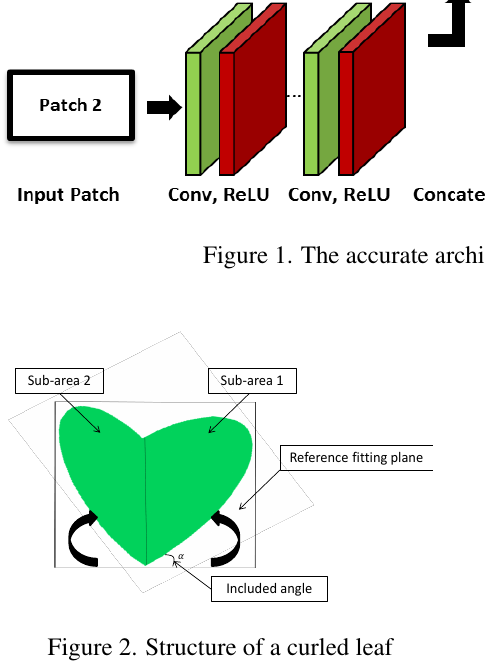
Figure 4. The extracted leaves area with one part highlighted in detail